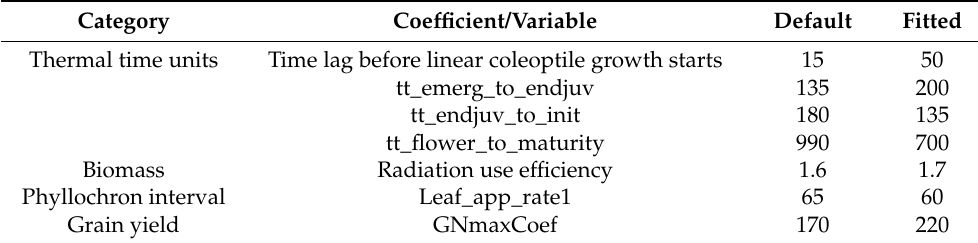
Table 2. Coefficient and variable modifications for the early cultivar in the APSIM Maize